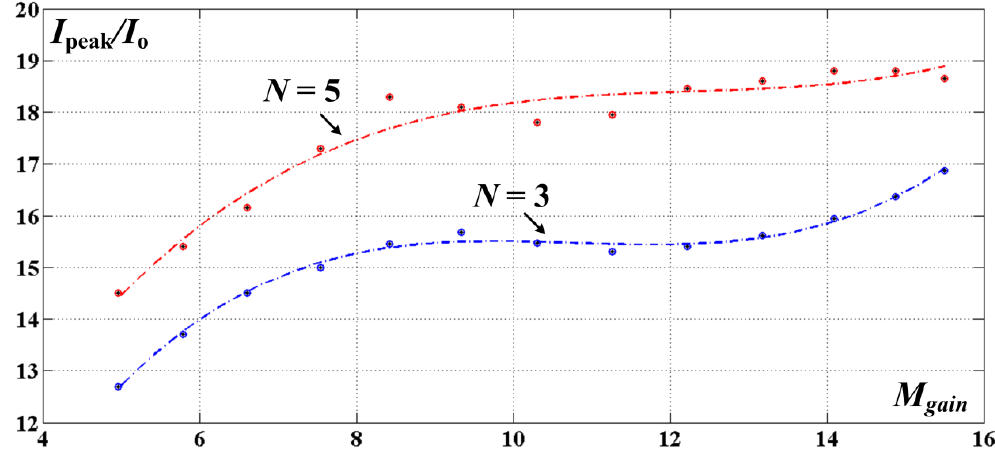
Figure 16. Comparison of input current